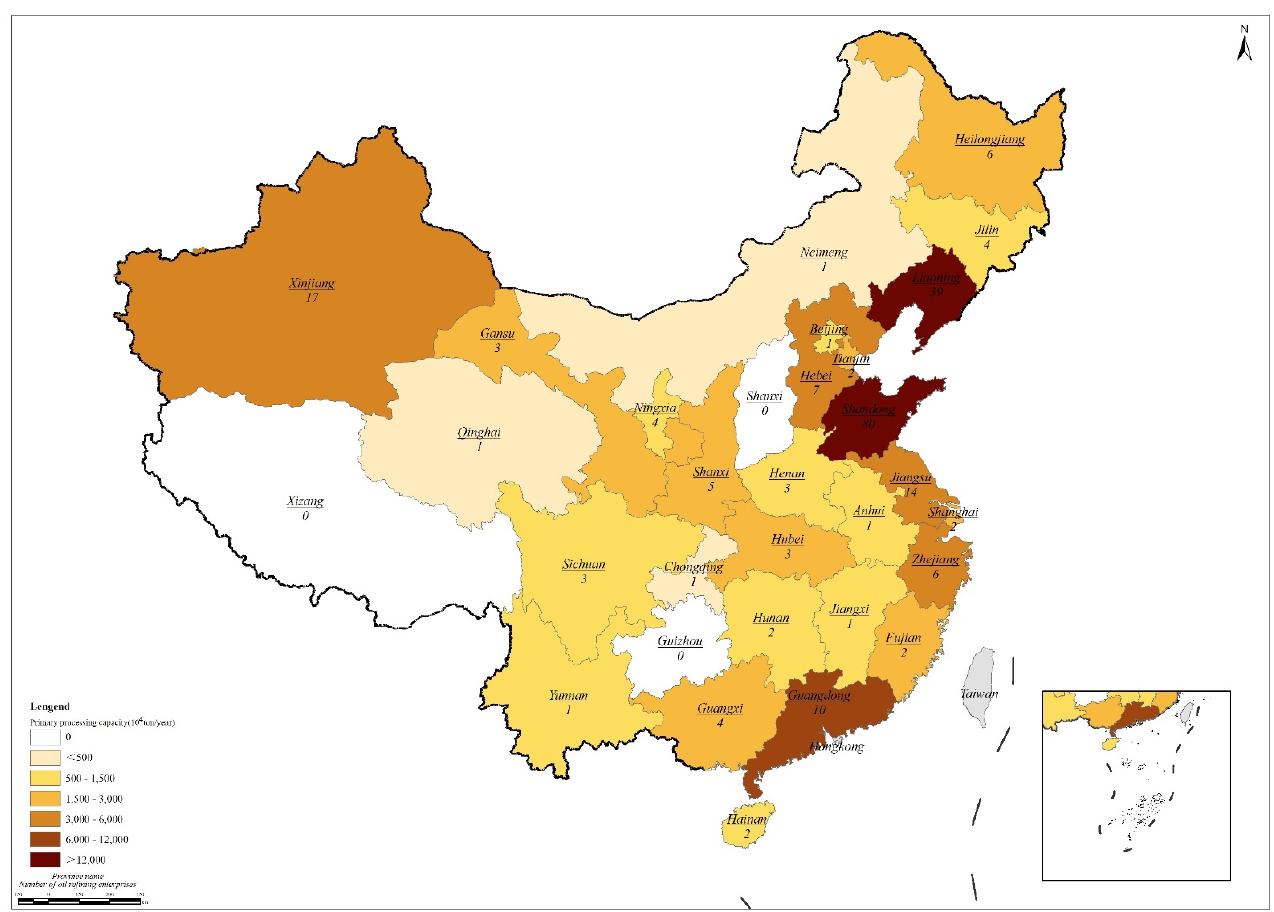
Figure 1. Number of petrochemical enterprises and distribution of refining capacity in China [29].